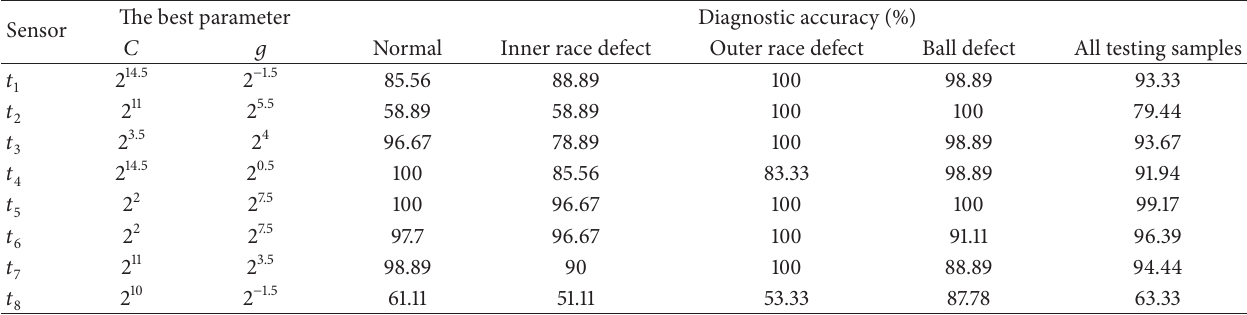
Table 5: Diagnostic results of rolling bearing by using different single